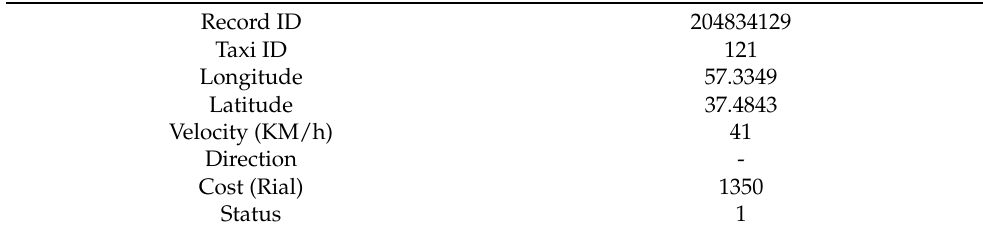
Table 1. A sample record of the data set.